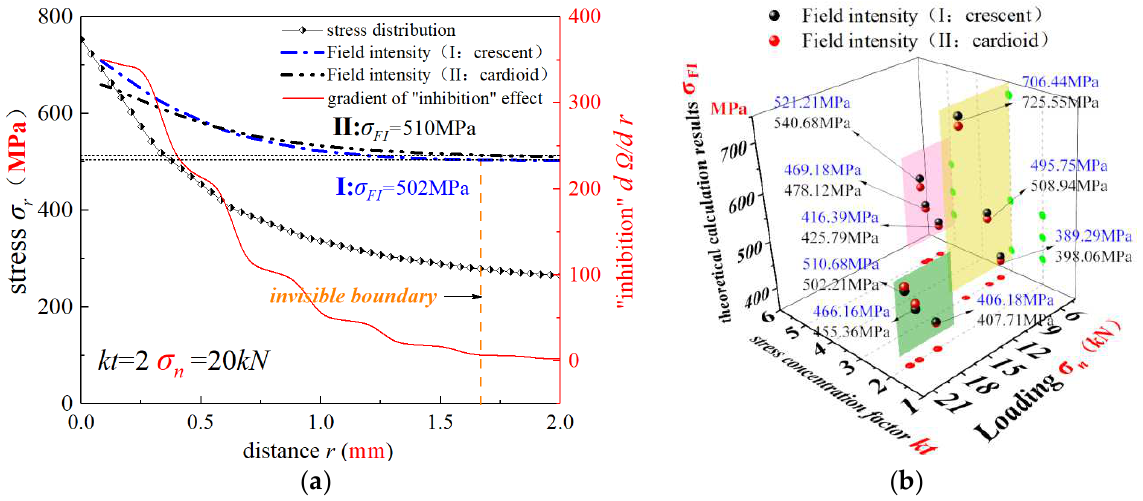
Figure 14. Analysis of stress fields near the notch by the simplified and improved SFI approach: ( a ) loading result for kt = 2 and σ n = 20 kN , and ( b ) theoretical calculation results for 9 different